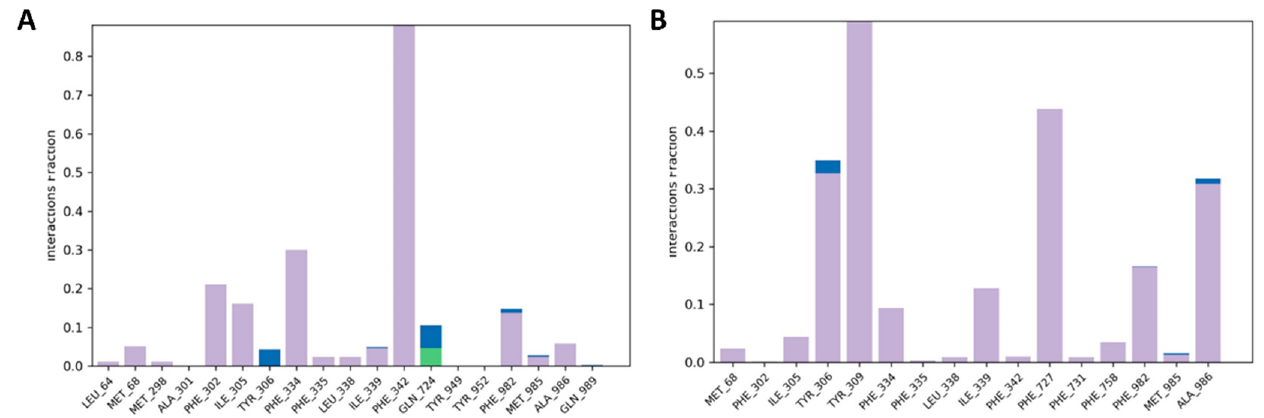
Figure 12. Protein-ligand contacts histogram and ligand interaction of compounds 7 ( A ) and 8 ( B ). Finally, the average free binding energy of both compounds ( 7 and 8 ) along with arte- sunate were calculated, and the result was shown in Table S3 of Supplementary Materials. The average binding free energy for 7 , 8, and artesunic acid were − 96.714, − 93.841, and − 70.435 kcal/mol, respectively. The binding affinity in the form of docking score values of compounds were − 8.196, − 7.089, and − 6.252 kcal/mol, which is satisfactory with the mea- sured free energy of binding. Based on the RMSD, RMSF, and MM-GBSA results showed that these selected compounds were found to be stable, and the P-gp protein-ligands con- formation remains unchanged. This further validated the in vitro results that compounds 7 and 8 exhibited an outstanding P-gp inhibitory activity at nanomolar